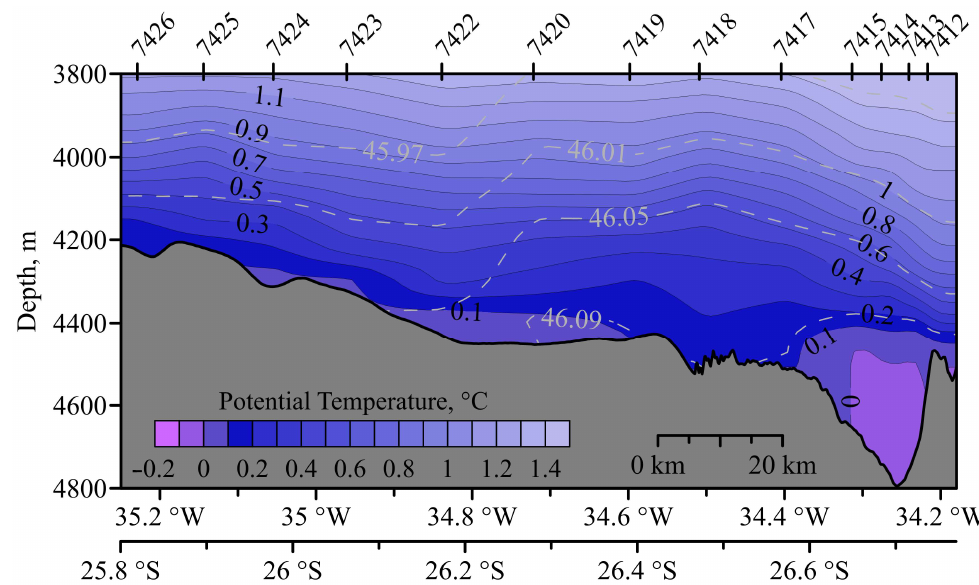
Figure 7. Potential temperature section of AABW outflow from the Vema Channel in 2022. The location of the section was slightly different from its position in 2003 (Figure 1). Contour lines of density (~46 units) are shown.